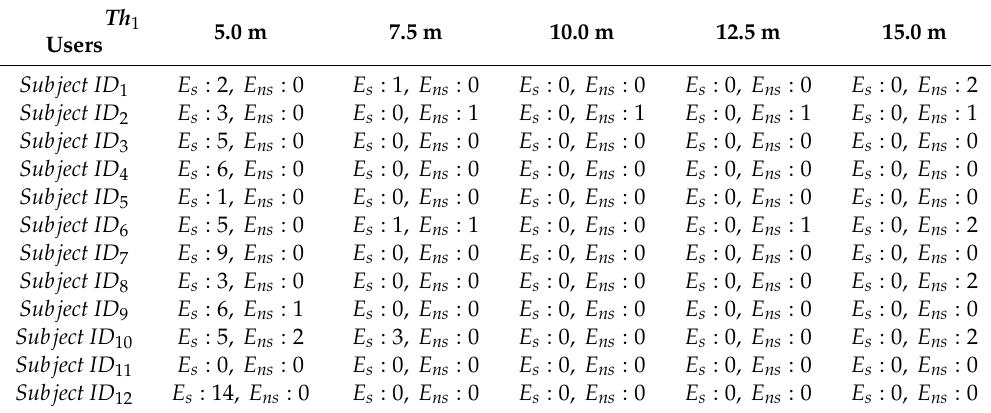
Table 2. Examinations of Th 1 , i.e., threshold for judging indoor or outdoor locations using the radius of certainty for the location as the horizontal GPS error according to user experiments. E s (cid:3435)(cid:1831)(cid:1870)(cid:1870)(cid:1867)(cid:1870) (cid:3046)(cid:3047)(cid:3028)(cid:3052)(cid:3036)(cid:3041)(cid:3034) (cid:3439) refers to the number of wrong recognitions in points of staying indoors while a user was outdoors. In contrast, (cid:1831) (cid:3041)(cid:3046) (cid:3435)(cid:1831)(cid:1870)(cid:1870)(cid:1867)(cid:1870) (cid:3041)(cid:3042)(cid:3047)(cid:3020)(cid:3047)(cid:3028)(cid:3052)(cid:3036)(cid:3041)(cid:3034) (cid:3439) represents the number of wrong recognitions in points of not staying indoors, i.e., staying outdoors while a user is still inside but near the outdoors, for example around windows.